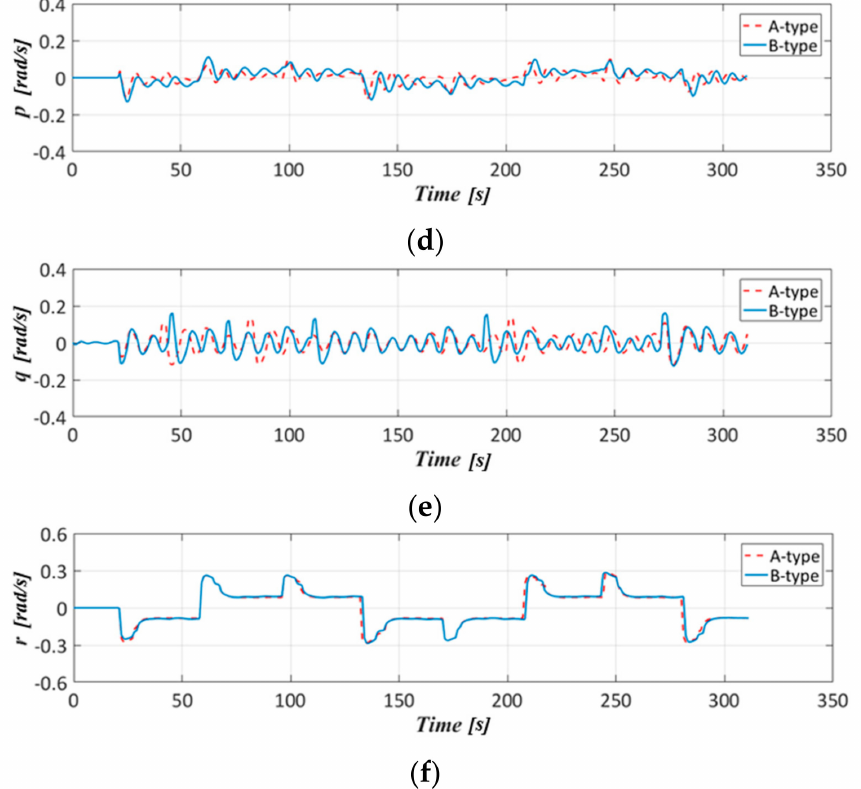
Figure 27. Time series of velocity components. ( a ) Surge rate: u [m/s], ( b ) sway rate: v [m/s], ( c ) heave rate: w [m/s], ( d ) roll rate: p [rad/s], ( e ) pitch rate: q [rad/s], and ( f ) yaw rate: r [rad/s] for the A-type and B-type controllers,